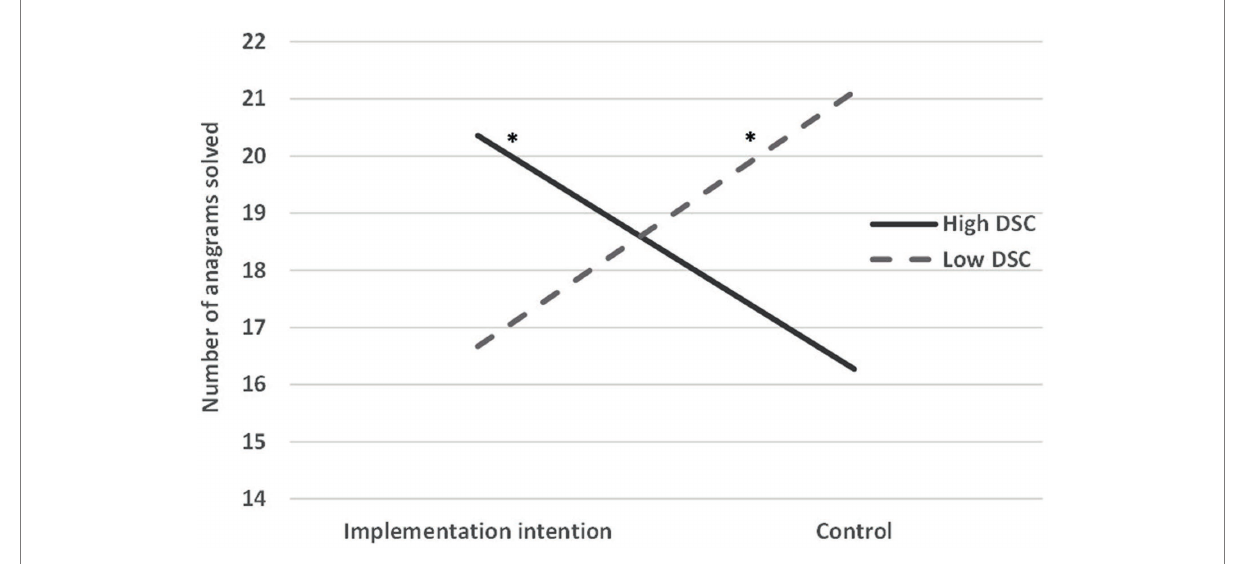
FIGURE 2 Performance on a self-control task as a function of desire for self-control and implementation intention (Study 2). DSC, Desire for self-control. * = p <